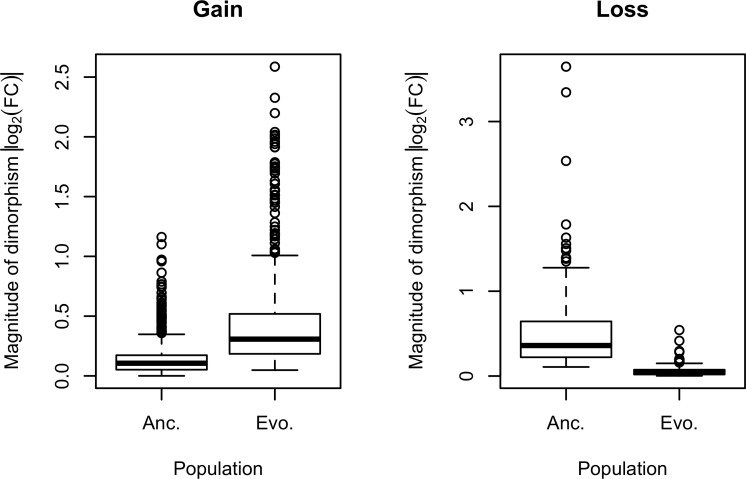
Evolution of sexual dimorphism.During the adaptation to the hot laboratory environment, 673 ancestrally unbiased genes evolved to exhibit significant expression dimorphism after 100 generations. Meanwhile, 136 genes evolved for a reduction in their sexual dimorphism. Sexual dimorphism can be dynamic when the underlying sex-specific fitness landscapes change over time. Selection on the standing genetic variation in the sex-biased regulatory architecture would tune the gain and loss of sexual dimorphism.